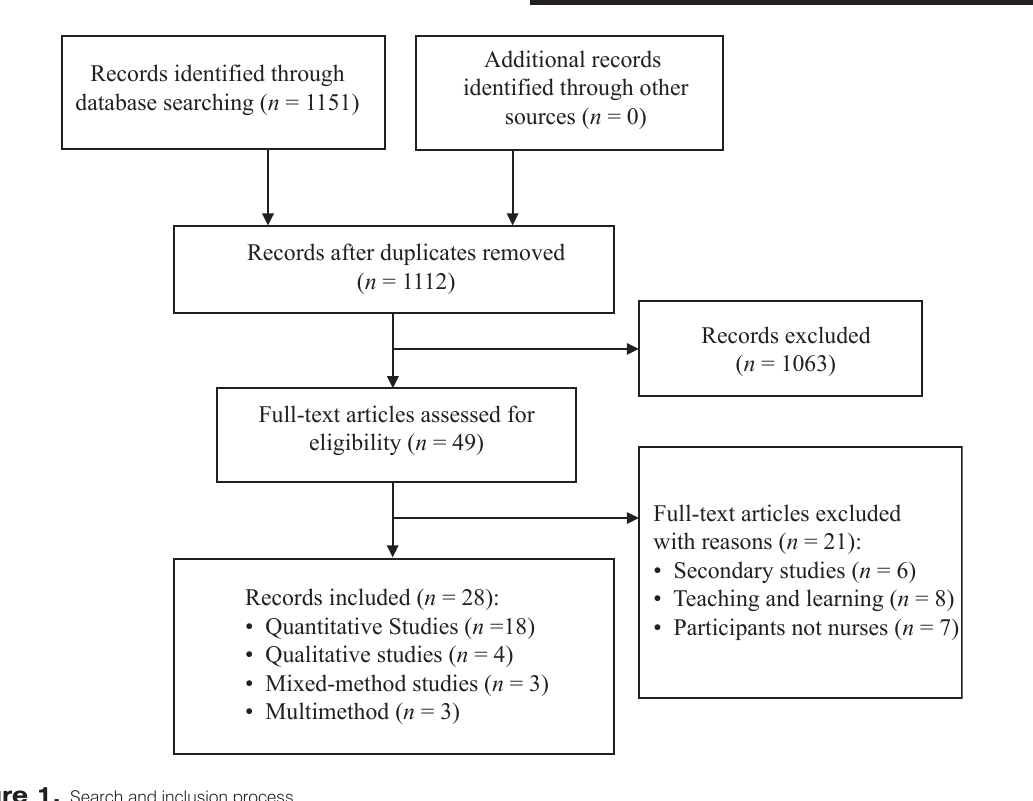
Figure 1. Search and inclusion process.